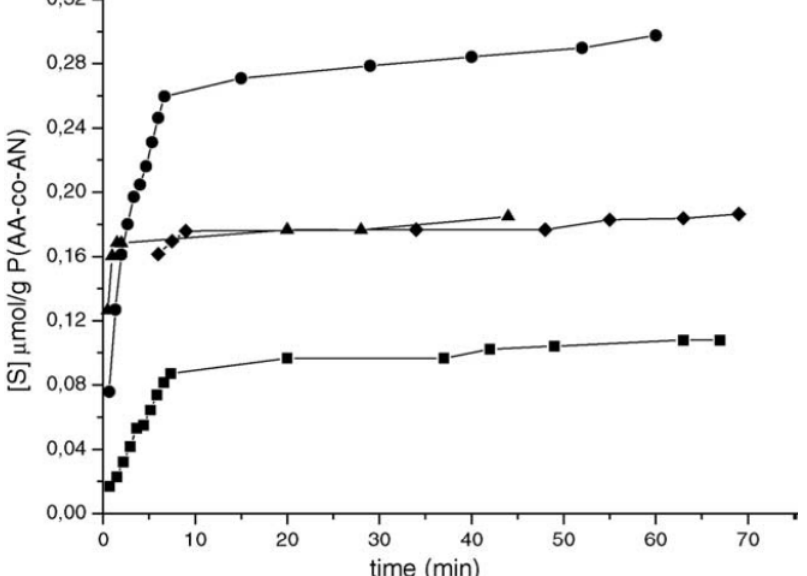
Figure 1. Uptaken amount of TCH and chloramphenicol in the MIM for TCH and NMIM: (  ) tetracycline hydrochloride into P(AA-co-AN) NMIM; (  ) TCH in the P(AA-co-AN) MIM; (  ) chloramphenicol in the P(AA-co-AN) MIM; (  ) chloramphenicol in the